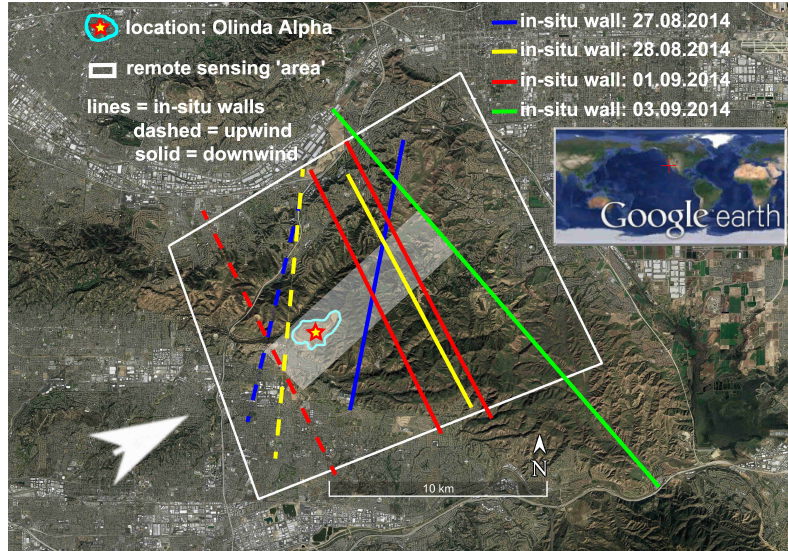
Figure 2. The Olinda Alpha Landfill is located at the position of the red/yellow star encircled by the cyan solid line. Additionally, the approximate positions of the flown in situ upwind (dashed lines) and downwind (solid lines) walls (see Sect. 2.3 for details) and the area which was surveyed by the MAMAP remote sensing instrument (white box) are shown. The colors of the in situ walls represent the different flight days at the Olinda Alpha Landfill: blue is 27 August 2014; yellow is 28 August 2014; red is 1 September 2014; green is 3 September 2014. The white arrow indicates the approximate prevailing wind direction for measurement flights over the Olinda Alpha Landfill. The transparent white area aligned in the approximate wind direction shows one example flight track of the AVIRIS-NG imaging instrument aboard the second Twin Otter aircraft for illustration purposes. The map underneath is provided by Google